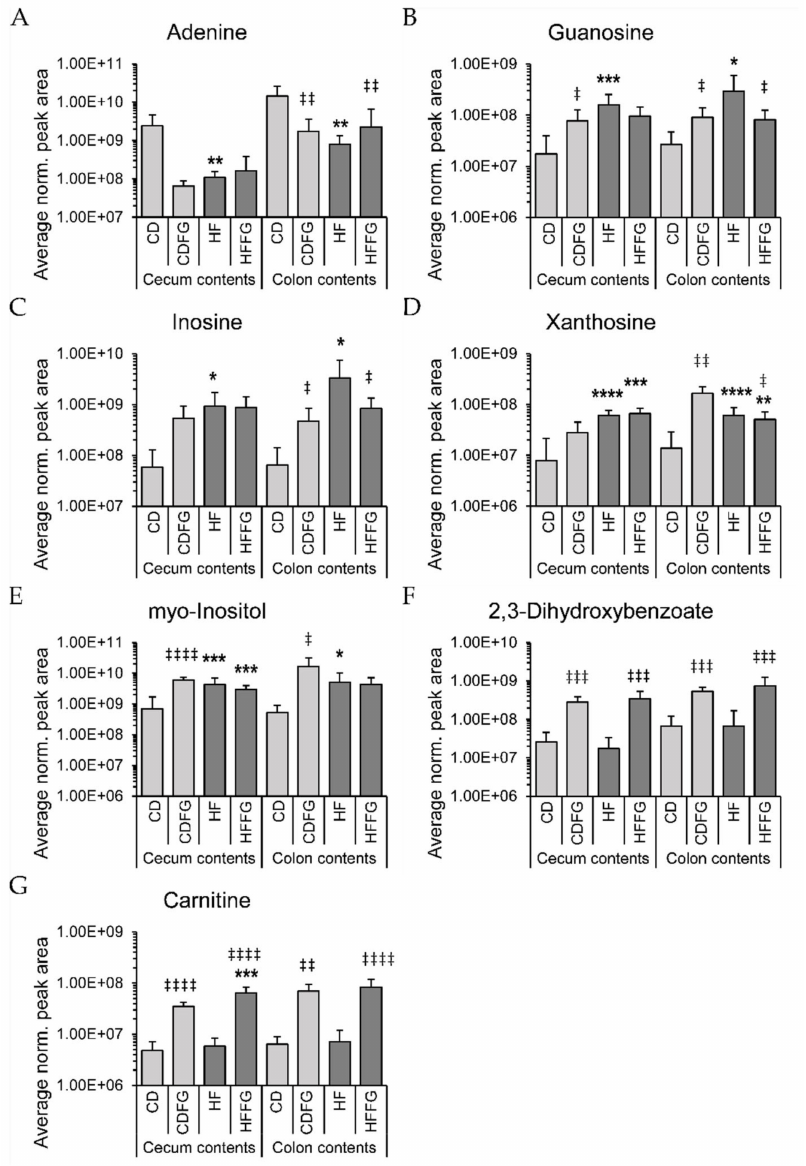
Figure 4. Normalized intensities of ( A ) adenine, ( B ) guanosine, ( C ) inosine, ( D ) xanthosine, ( E ) myo- inositol, ( F ) 2,3-dihydroxybenzoate, and ( G ) carnitine from both cecum and colon data. Data were normalized according to mass and the normalized peak area is represented on a log 10 scale as mean ± standard deviation. Significance was determined using a student’s t -test. Significance is represented as * p < 0.05, ** p < 0.01, *** p < 0.001, and **** p < 0.0001 for comparisons against respective CD groups or ‡ p < 0.05, ‡‡ p < 0.01, ‡‡‡ p < 0.001, and ‡‡‡‡ p < 0.0001 for comparisons against either HF or CD,